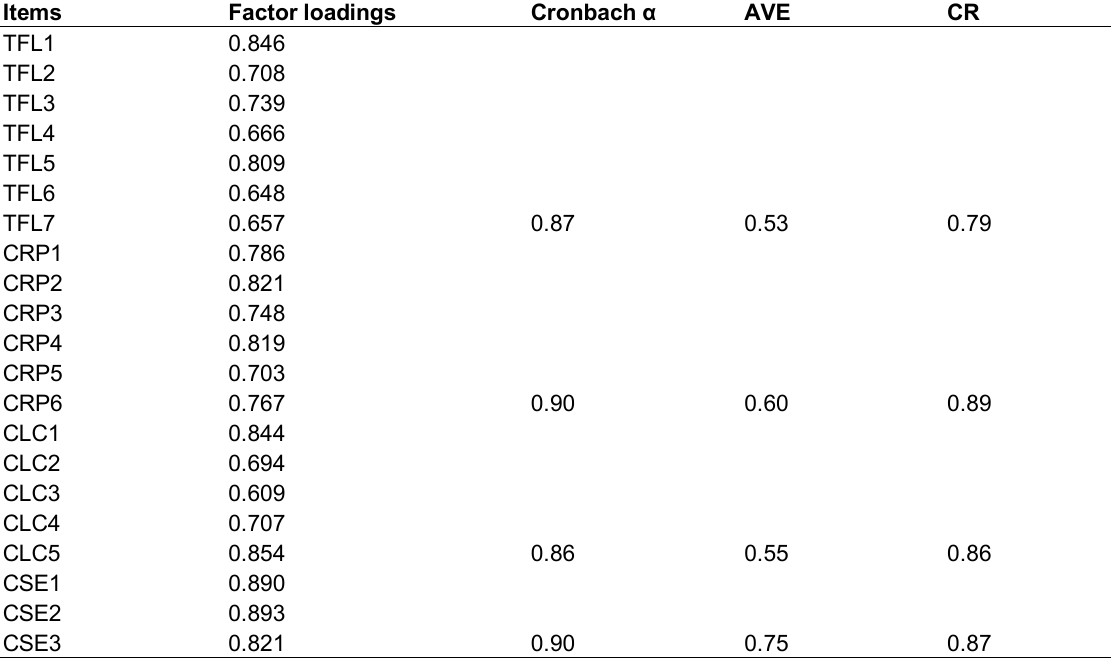
Table 3: Reliability and